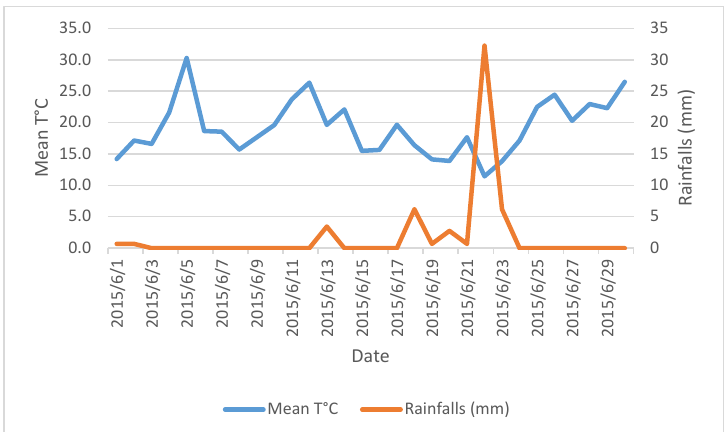
Animals 2022 , 12 , x Figure 2. Weather conditions recorded in June 2015.